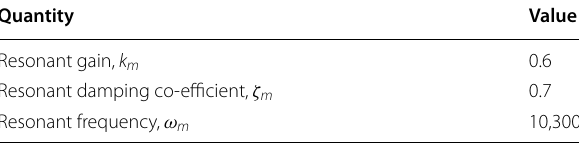
Table 4 Parameters of MIMO NI‑RLLC controller